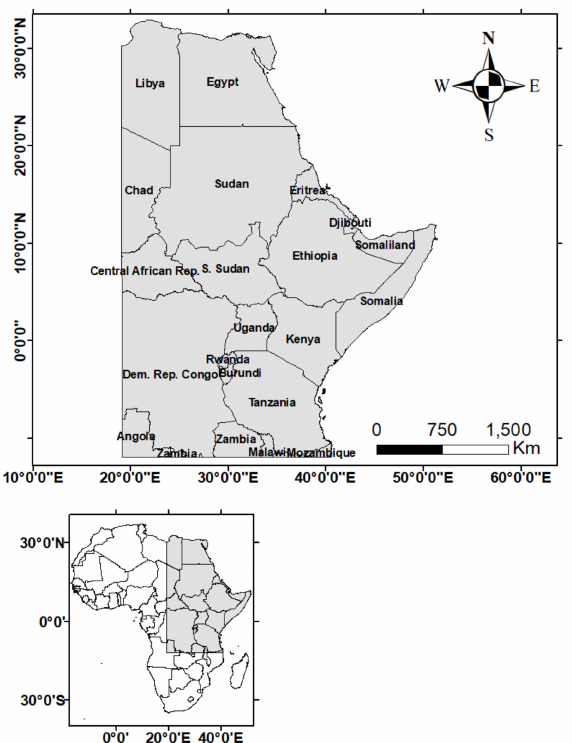
Figure 1. Study area, shaded in gray, and its location in the continent of